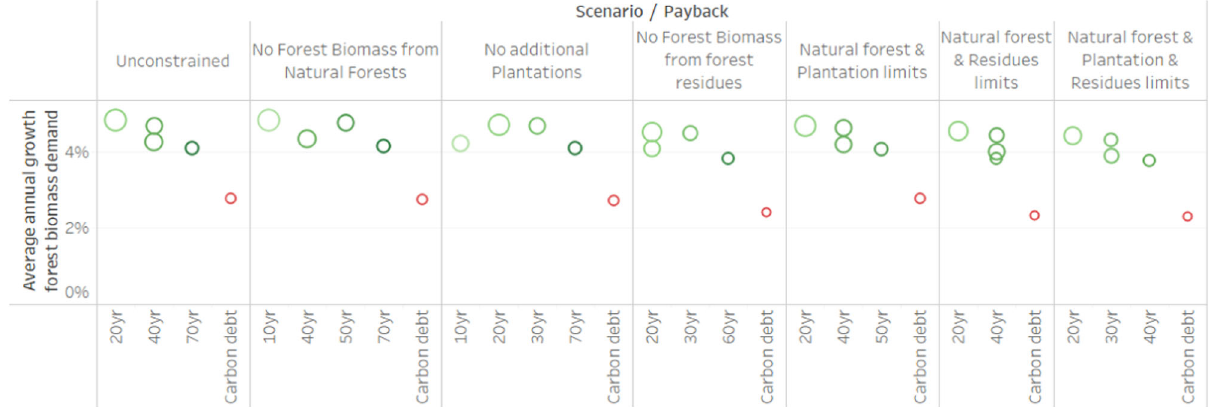
Fig. 5 Payback period of forest carbon debt under 5 representative demand scenarios by annual average forest biomass demand growth rate for 2020 – 2100 under different constraints on forest biomass supply 2020 – 2100 (all carbon pools included). Each circle shows the payback period of the forest carbon debt per scenario according to the annual average forest biomass demand growth rate ( y -axis) across seven supply scenarios as described in Supplementary Table 2. All carbon pools are included in the carbon debt calculation. The color of the circle identi fi es the payback period: scenarios that never recover the carbon debt are in red (permanent carbon debt) and scenarios that recover it between 10 and 40 years are in green. The size of the circle represents the global annual average biomass quantity supplied between 2020 and 2100 and it ranges from 100 to 900 Mm 3